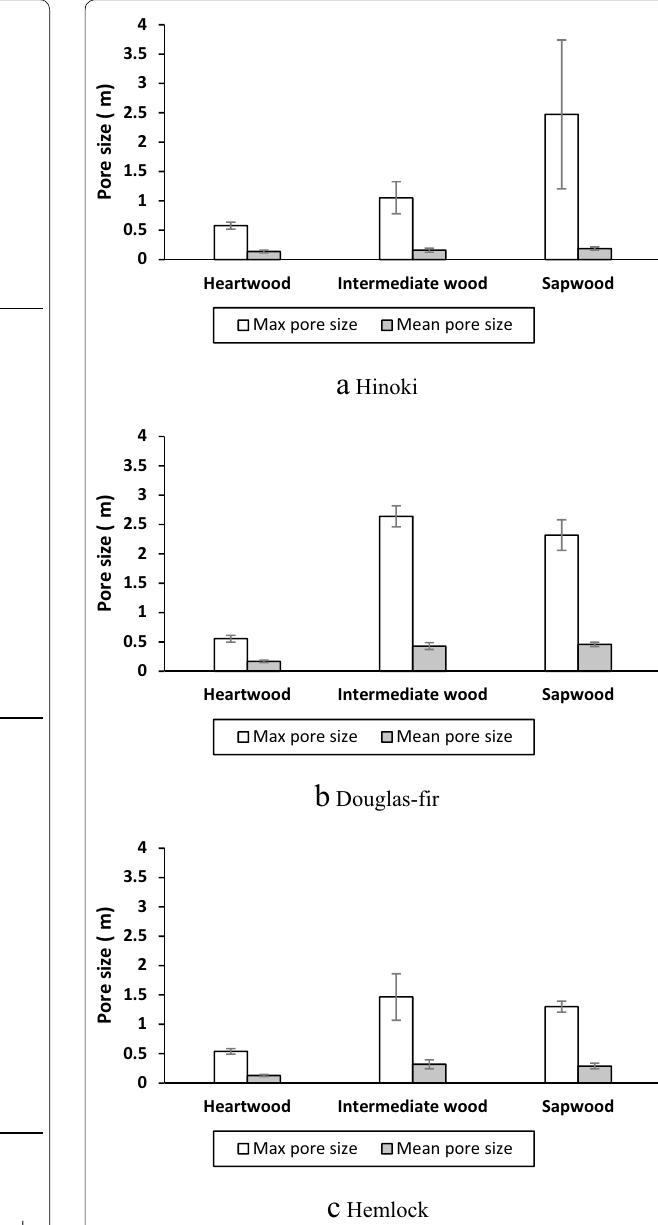
Fig. 6 Results of through pore size of heartwood, intermediate wood and sapwood in three species of softwood (error bar; standard